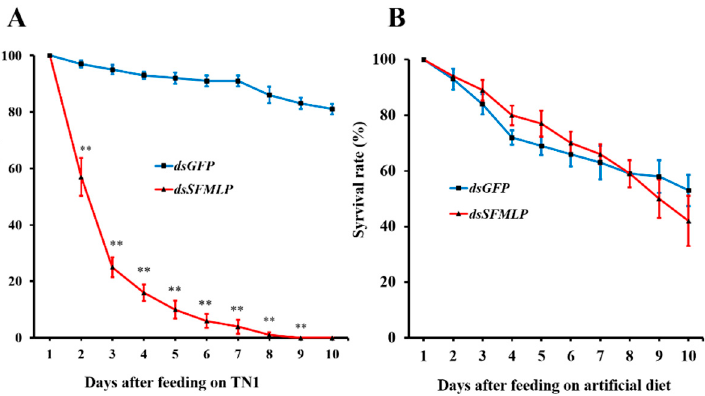
Figure 3. Effects of SFMLP knockdown on the survival rates of WBPH. ds GFP indicates WBPH injected with GFP - dsRNA ; dsSFMLP indicates WBPH injected with SFMLP - dsRNA . ( A ) The survival rates of WBPH feeding on TN1; ( B ) the survival rates of WBPH feeding on artificial diet. “**” indicates statistically significant differences ( t test: p < 0.01). Bars, ±SEM.